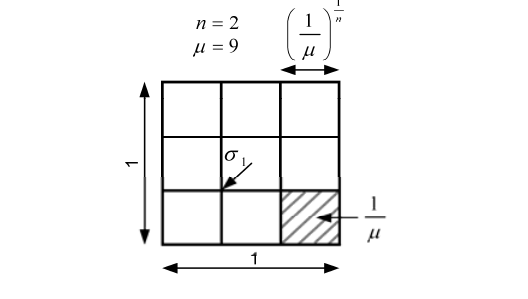
Fig. 3 Graphical example of the meaning of